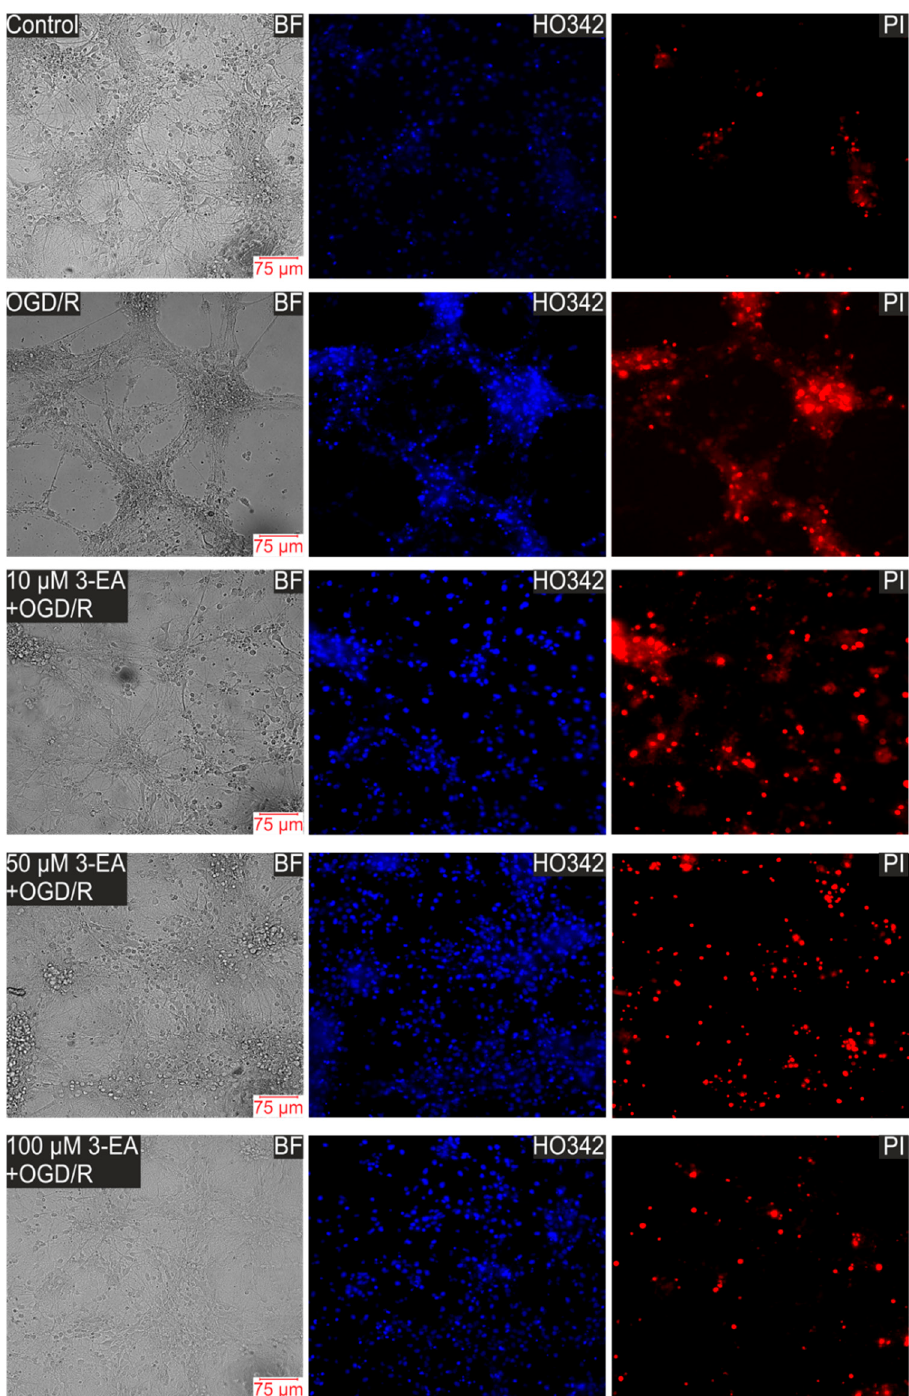
Figure A1. Double staining of cells with Hoechst 33342 (HO342) and Propidium iodide (PI) in control (no exposure), after 2-h OGD with 24-h reoxygenation (OGD/R), and after OGD/R in presence of various 3-EA’s concentrations. 3-EA was added 24 h prior to OGD/R induction and 3-EA concentrations were maintained throughout the duration of OGD/R exposure. BF—bright-field microscopy.